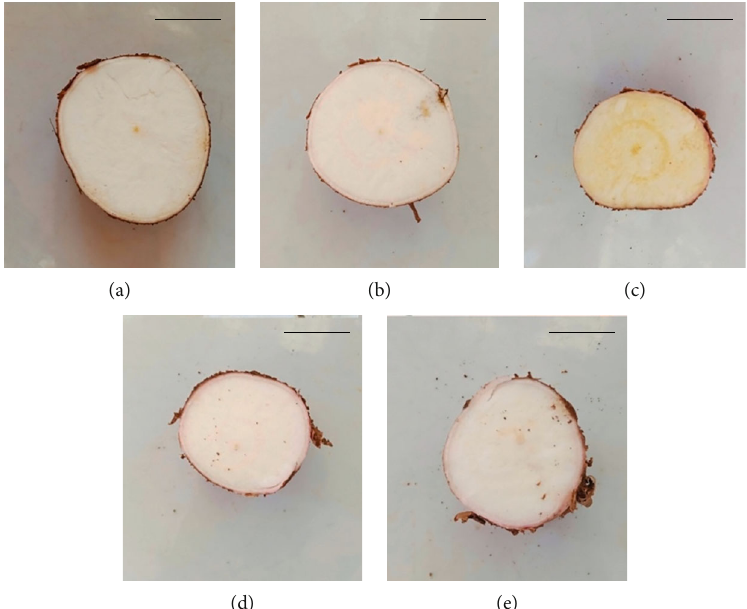
Figure 2: Cross sections of mature roots of selected Sri Lankan cassava varieties: (a) Kirikawadi , (b) MU51, (c) Swarna , (d) Shani , and (e) Suranimala . Scale bar = 20mm